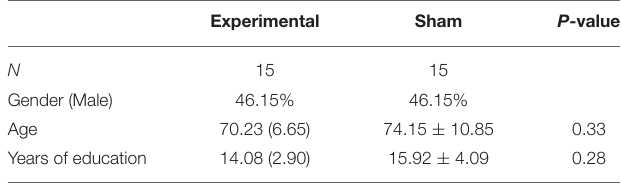
TABLE 1 | Baseline demographic data of the study participants according to group.